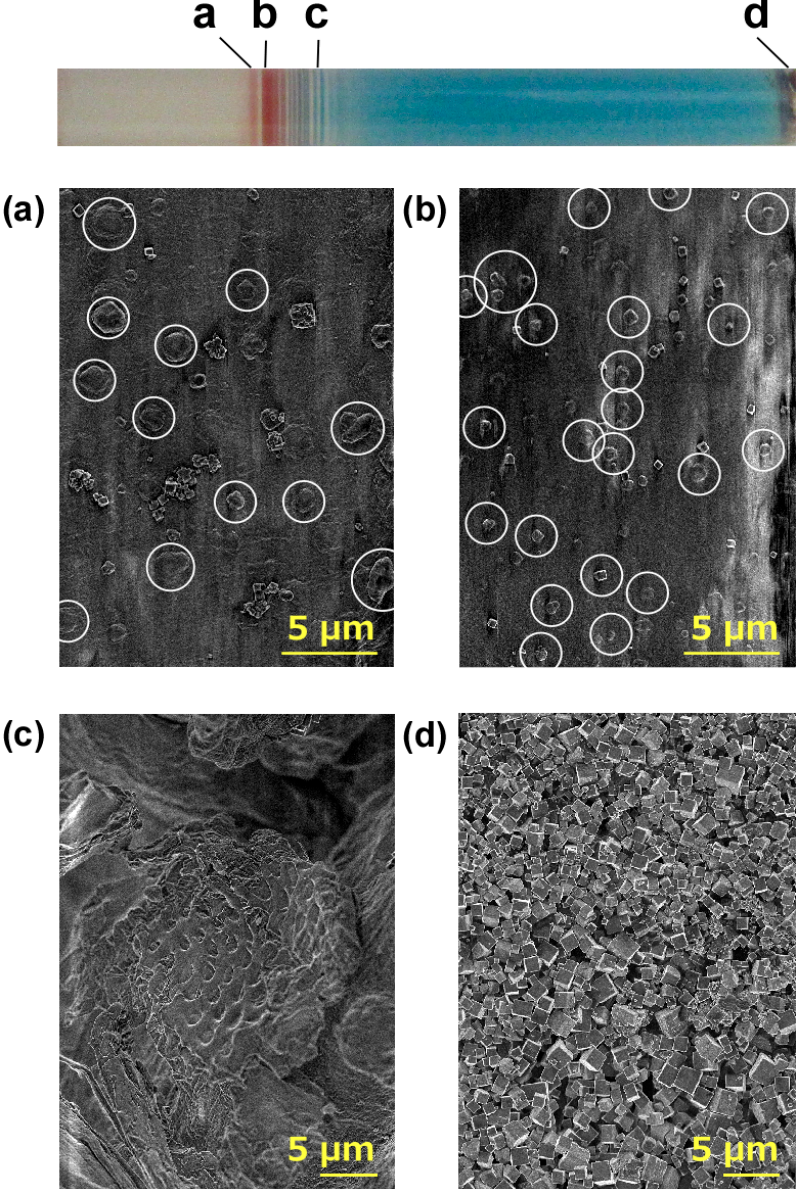
Figure 13. SEM images (×5000 for ( a ) and ( b ); × 3000 for ( c ) and ( d )) of the multicolored pattern formed under the cyclic alternating voltage application, obtained after removing unreacted ions. The positions where these SEM images were acquired are indicated in the uppermost panel. The plate-like crystallites in ( a ) and the irregularly shaped (albeit cube-like) crystallites in ( b ) are indicated by white circles to guide the eye. Scale bars (which were employed for estimating the sizes of the crystallites) are provided in each image.